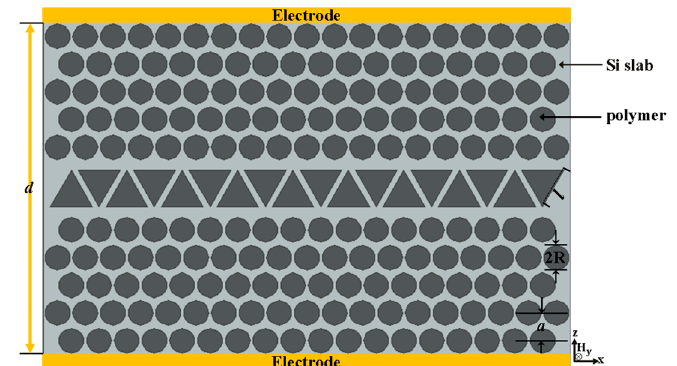
Figure 5. Schematic conformation of the dynamic modulation for the optimum EPCW R = 0.45𝑎,𝑙 = 1.50𝑎 and 𝑎 = 0.5084 μm .